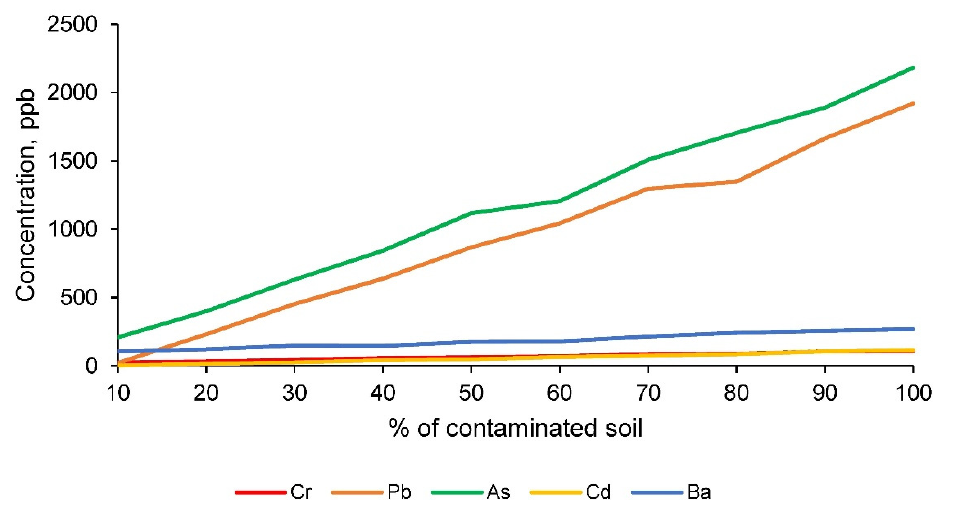
Figure 10. Concentration of toxic elements in the leachate, obtained according to the TCLP leaching test, for the families of clay and contaminated soil conformed